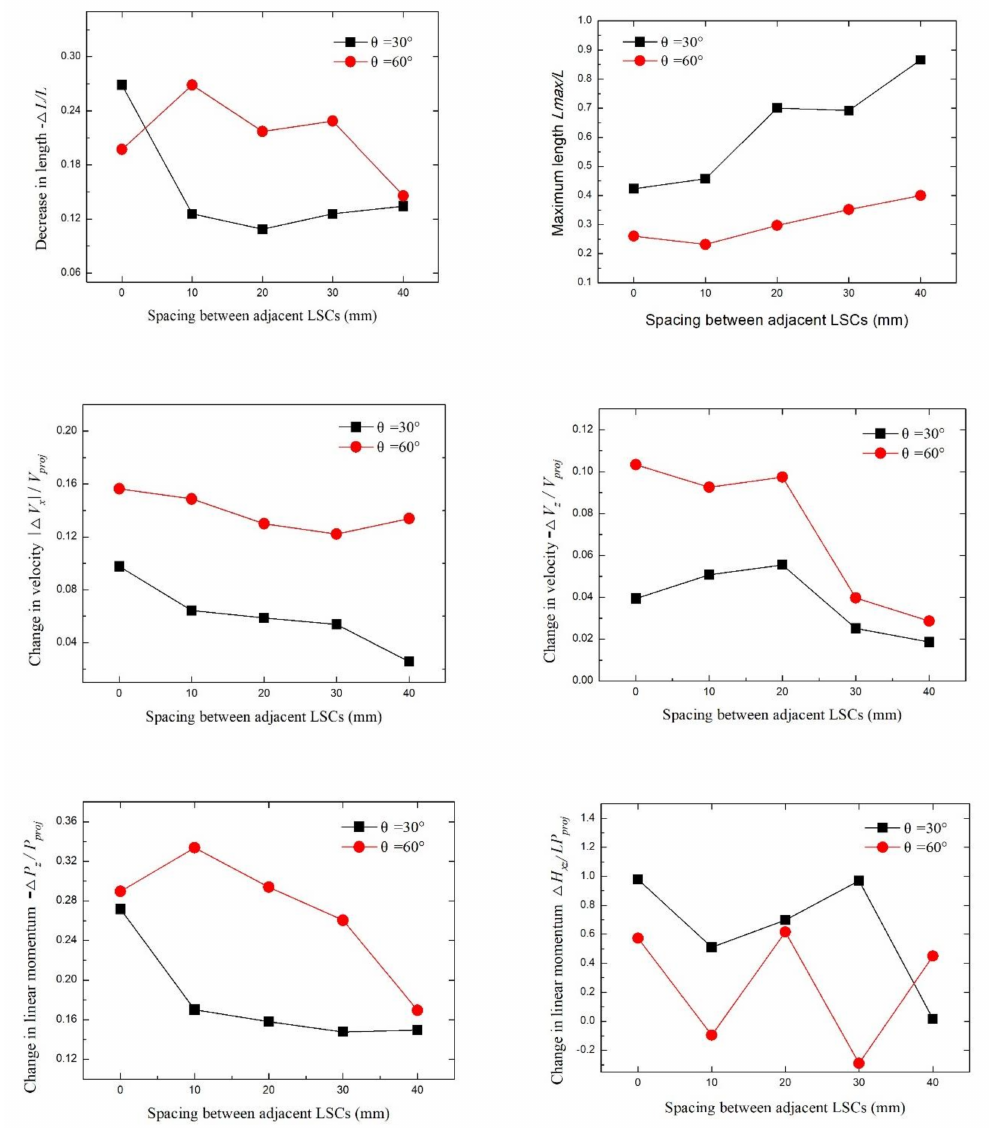
Figure 17. Influence of the LSC spacing at di ff erent inclination